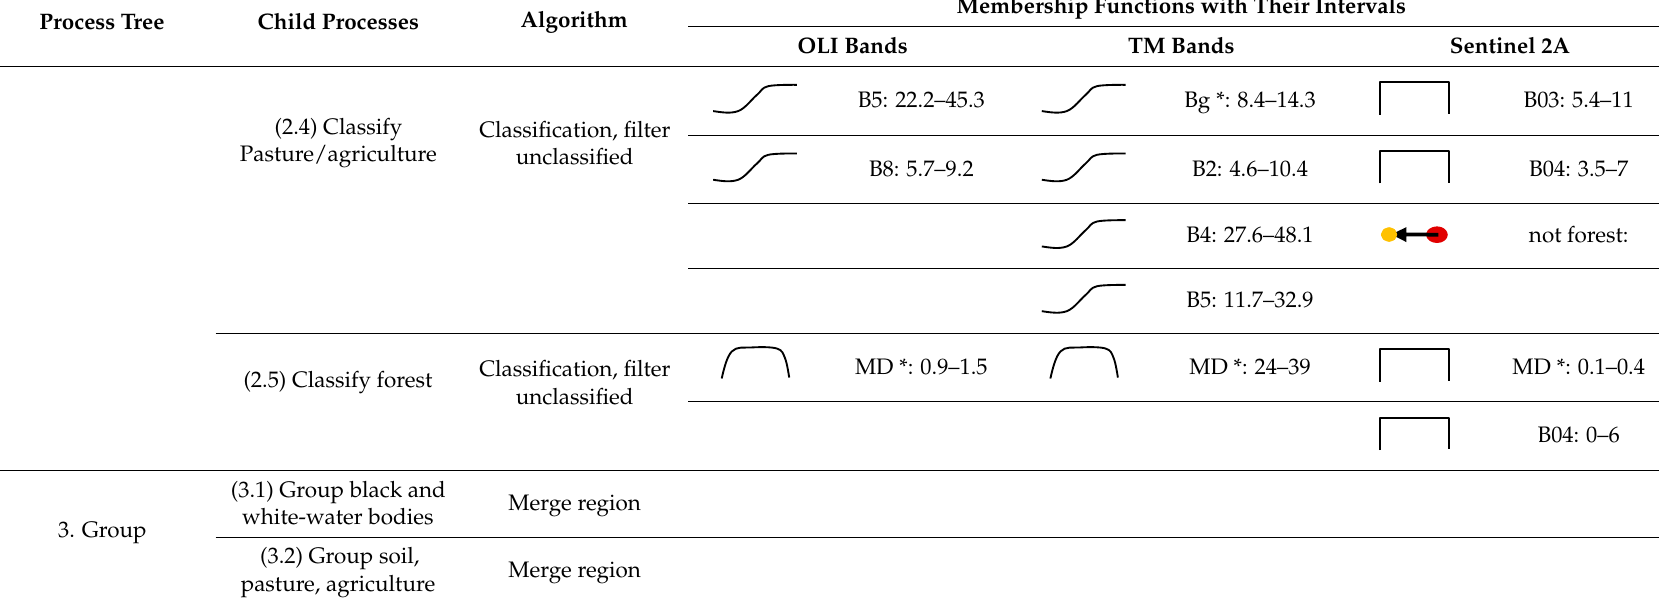
Table 1. The process tree, child processes, algorithms, and membership functions used in the LCLU classification following the GEOBIA approach.